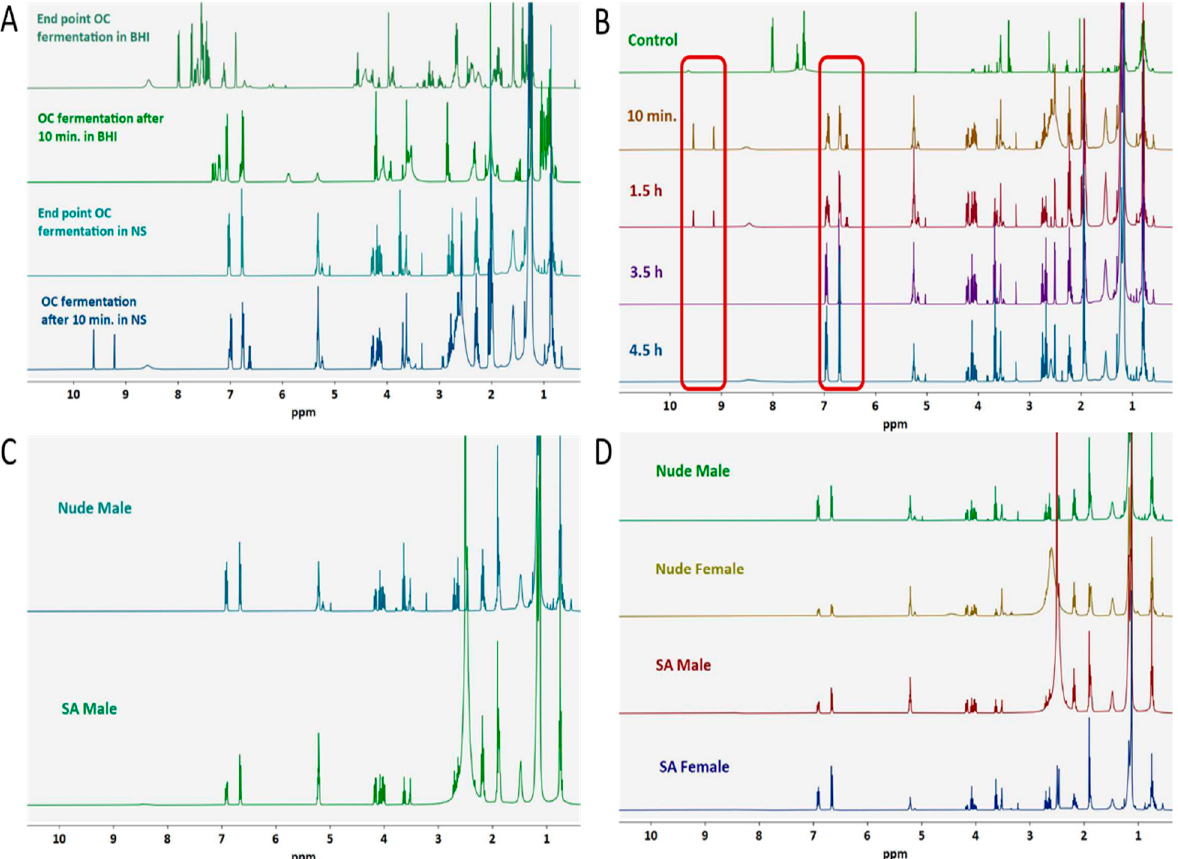
Figure 3. 1 H NMR (400 MHz, in CDCl 3 )-guided monitoring of OC depletion based on tracking of the OC C-1 aldehyde proton at δ 9.22 and C-3 aldehyde proton at δ 9.63. Optimization variables included anaerobic fermentation media and time, and mouse species and gender. ( A ) Fermentation media optimization. Fermentation of 10 mg OC per 250 mg fresh feces by using BHI broth versus